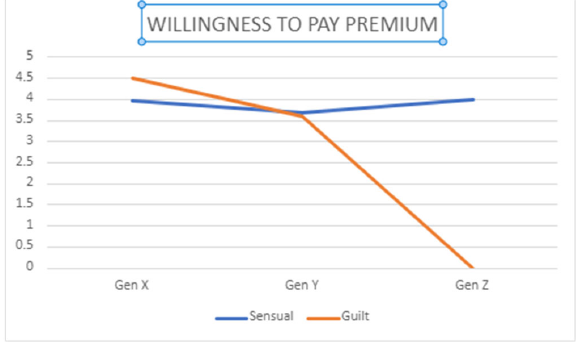
Fig. 4. The interaction effect of generations